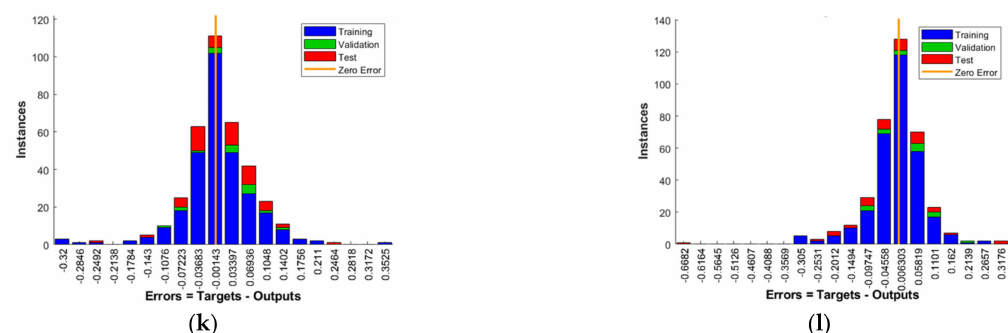
Figure 2. Error histogram for model: ( a ) COMP_NN70_10_20-41; ( b ) COMP_NN80_10_10-60; ( c ) COMP_NN80_5_15- 20; ( d ) COMP_NN85_5_10-41; ( e ) FLEX_NN70_10_20-48; ( f ) FLEX_NN80_10_10-48; ( g ) FLEX_NN80_5_15-16; ( h ) FLEX_NN85_5_10-16; ( i ) C+F_NN70_10_20-33; ( j ) C+F_NN80_10_10-11; ( k ) C+F_NN80_5_15-11; ( l )